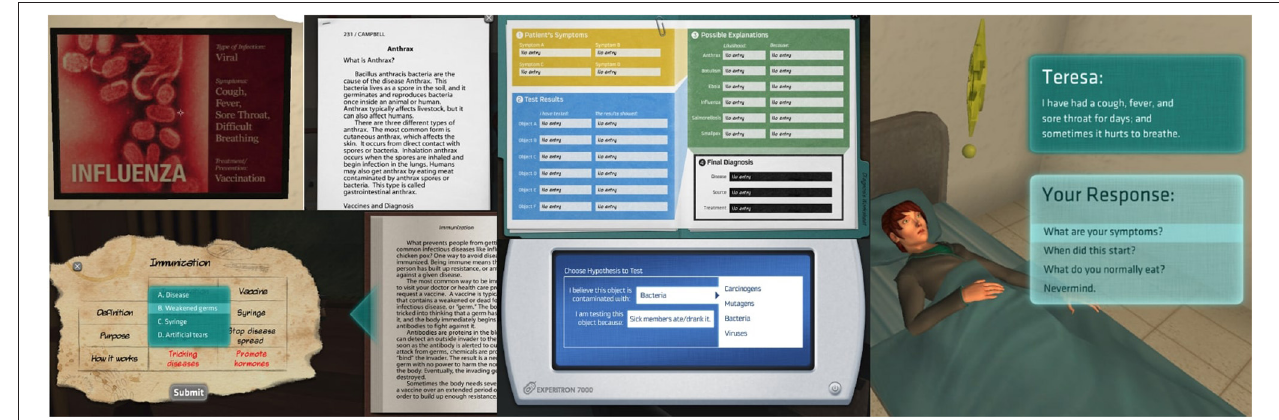
FIGURE 2 | Elements within the Crystal Island